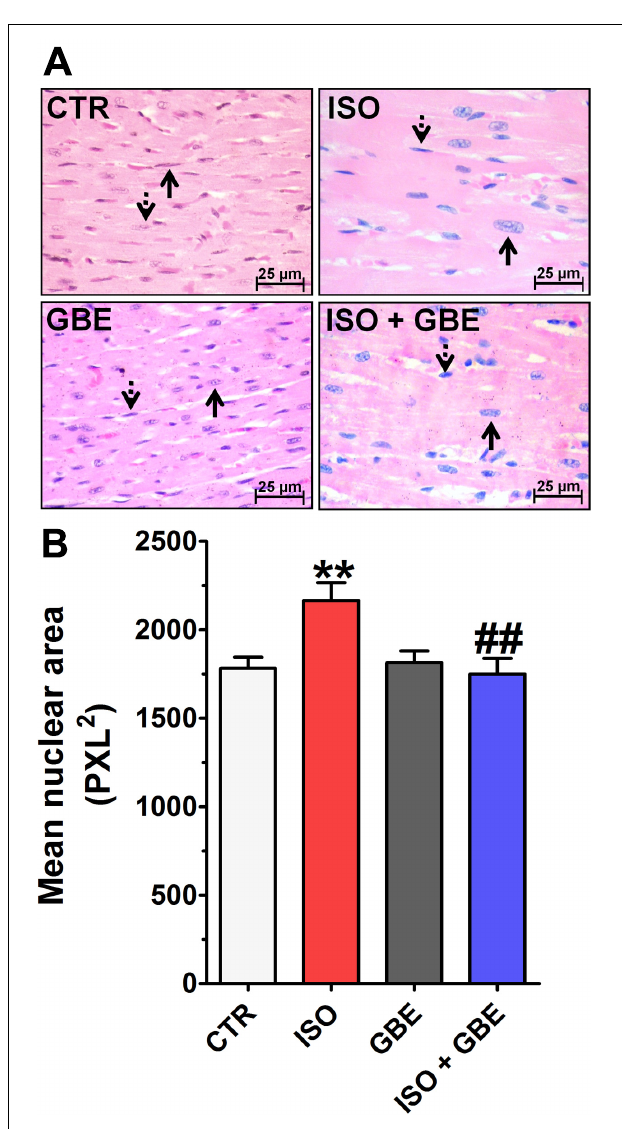
FIGURE 4 | Ginkgo biloba extract prevents the development of cardiac hypertrophy induced by chronic β -adrenergic stimulation. (A) Histological sections of the left ventricle stained with hematoxylin-eosin in each group. The arrows highlight the cellular nucleus for each group. (B) Quantitative analysis of mean nuclear area in all assessed groups. Data are represented as means ± SEM, ( n = 3). ∗∗ p < 0.01 vs. CTR, ## p < 0.01 vs. ISO, one-way ANOVA followed by Bonferroni’s post-test.